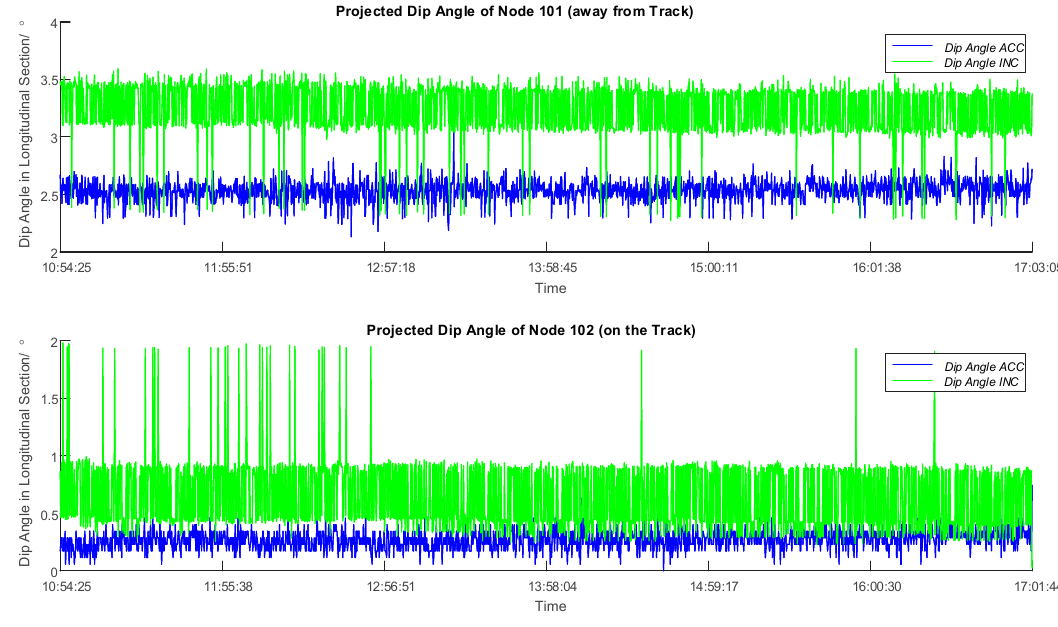
Figure 9. Plots of Dip Angles of Sensor Node 101 (away from Track) and Node 102 (on the Track) in the Longitudinal Section over the Observing Day. Blue and green lines stand for the performances of the accelerometer and the inclinometer. Vertical bars can be recognized as outliers.